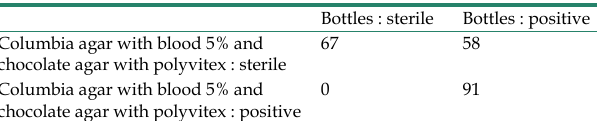
Bottles : sterile Bottles : positive 67 58